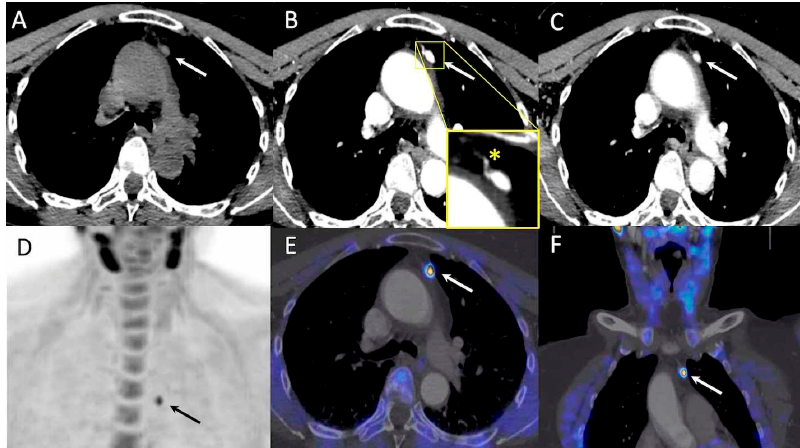
Table 2. Characteristics of hyperfunctioning parathyroids from 44 operated patients